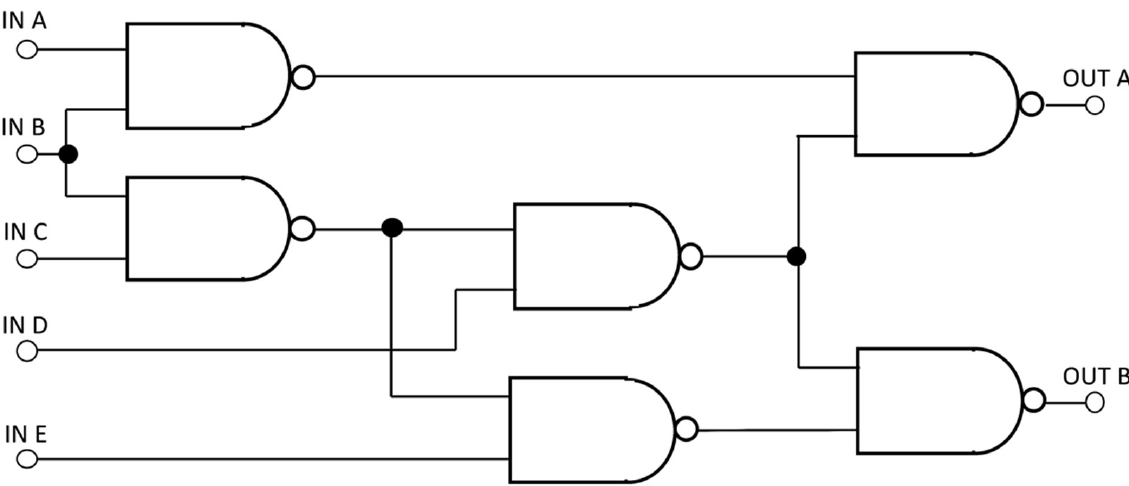
Figure 18. The logic diagram of the C17 ISCAS benchmark.